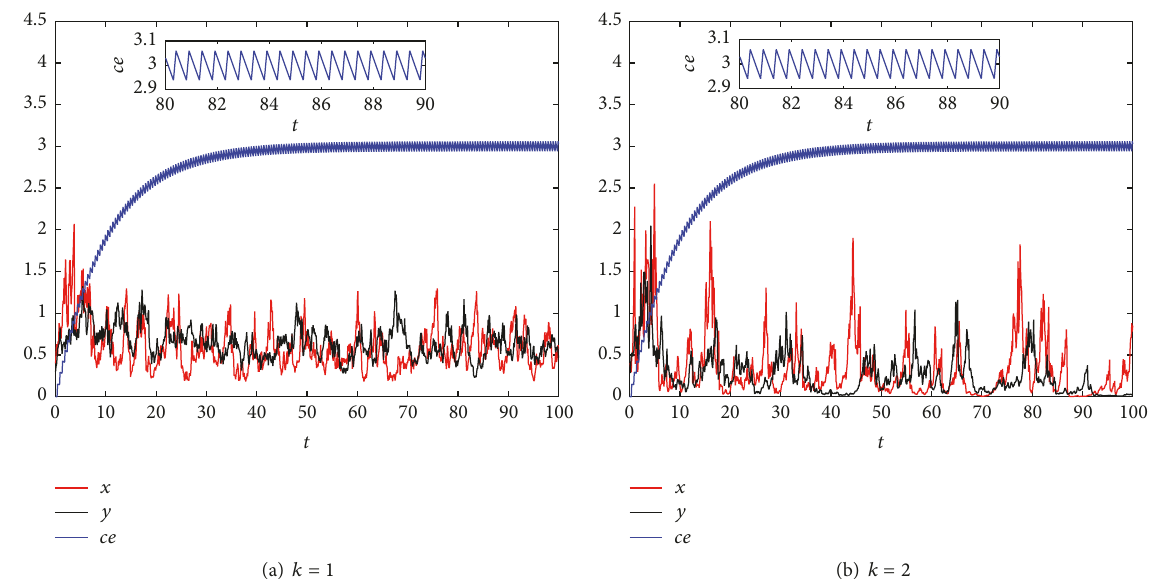
Figure 4: Sample paths of 𝑥(𝑡) , 𝑦(𝑡) with initial value 𝑥(0) = 0.4 and 𝑦(0) = 0.3